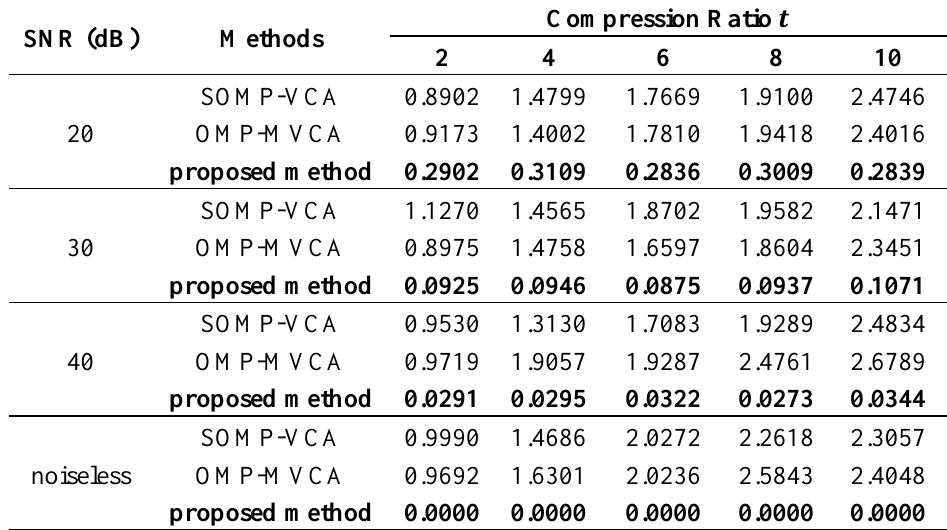
Table 4. Rural HSI: the standard deviations of rmsSAE of the proposed method, SOMP-VCA method and OMP-MVCA method under different noise levels.